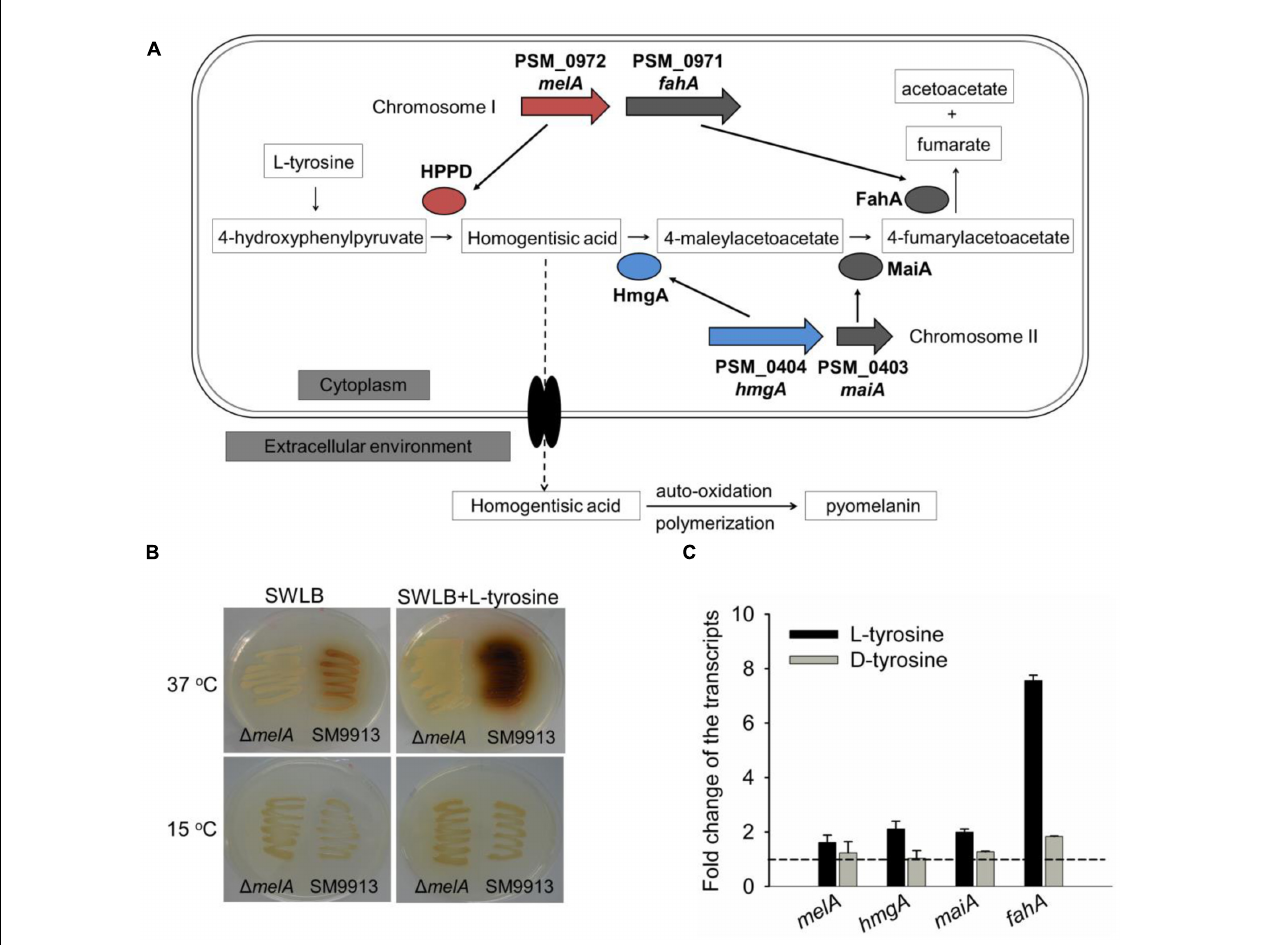
FIGURE 5 | Key enzymes involved in L -tyrosine catabolism in SM9913. (A) Predicted catabolic pathway of L -tyrosine and representative loci in the SM9913 genome. The predicted enzymes HPPD, HmgA, FahA, and MaiA encoded by melA , hmgA , fahA, and maiA located on the two different chromosomes are shown. The accumulation of HGA could secret to extracellular environment and the auto-oxidization of HGA lead to the production of pyomelanin. (B) Pigmentation of SM9913 and (cid:49) melA strains grown on SWLB agar plates or SWLB agar plates supplemented with 1 mg/mL L -tyrosine at 15 or 37 ◦ C, respectively. Three independent cultures were tested and one representative image is shown. (C) Fold changes of the melA , hmgA , maiA , and fahA transcription with or without L -tyrosine or D -tyrosine supplementation. Data are the average of three independent cultures, and one standard deviation is